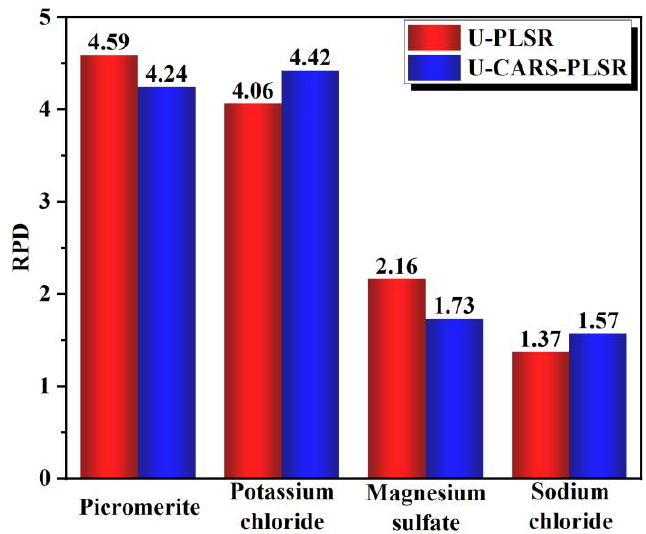
Figure 12. RPD values of four minerals in U-PLSR and U-PCARS-PLSR models.